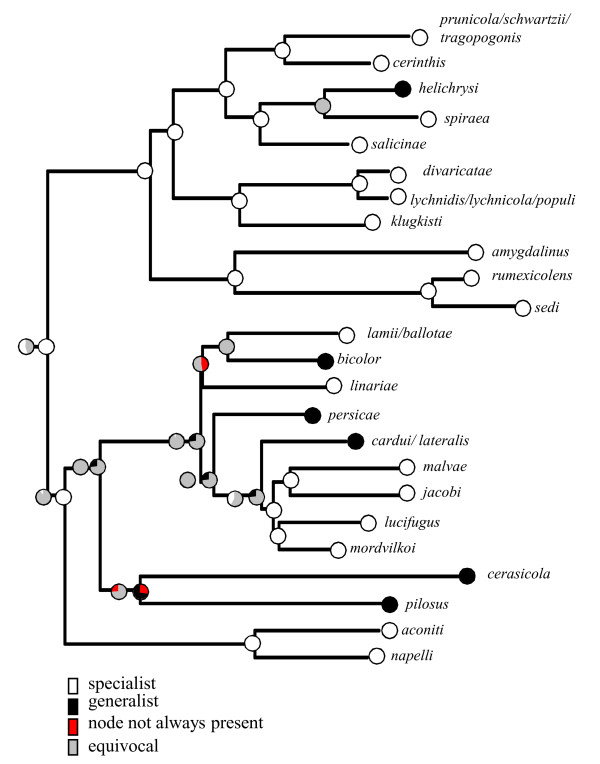
Host range breadth evolution shown on one Bayesian species tree. Pie charts at nodes show the % of trees for which the character state at this node was identified as the uniquely best state. ML optimization is given by the first pie chart on the left and MP optimization by the second pie chart